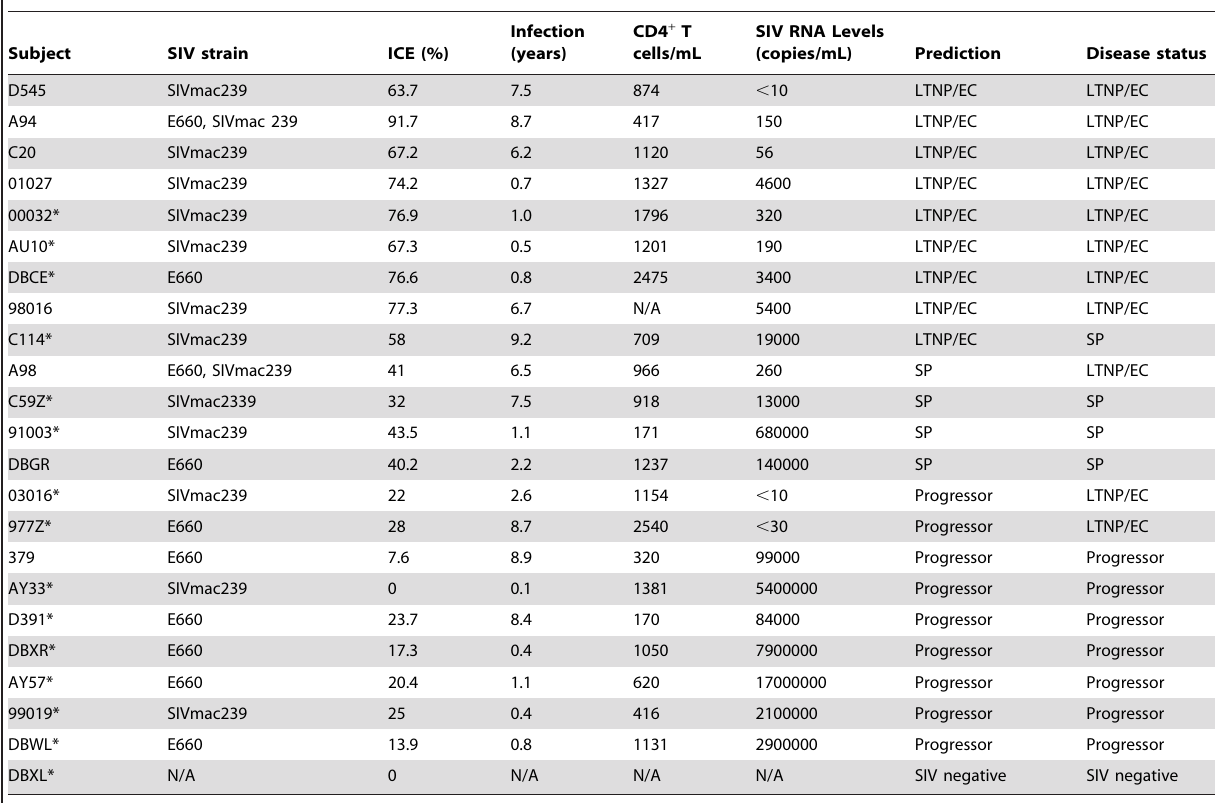
Table 1. Characteristics of macaques and prediction of SIV